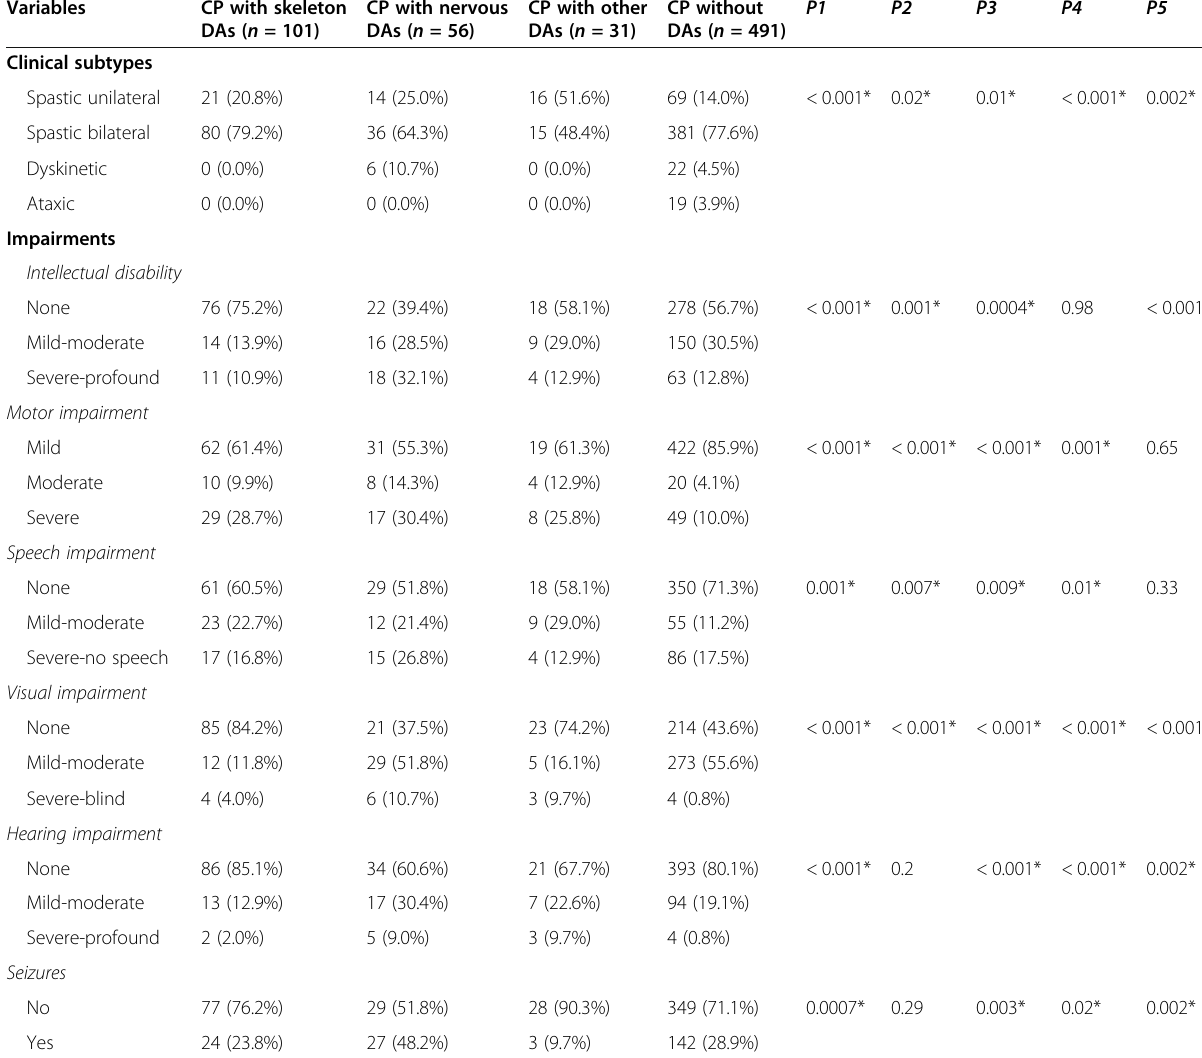
Table 3 Cerebral palsy (CP) subtypes and impairments among children with and without developmental anomalies (DAs)